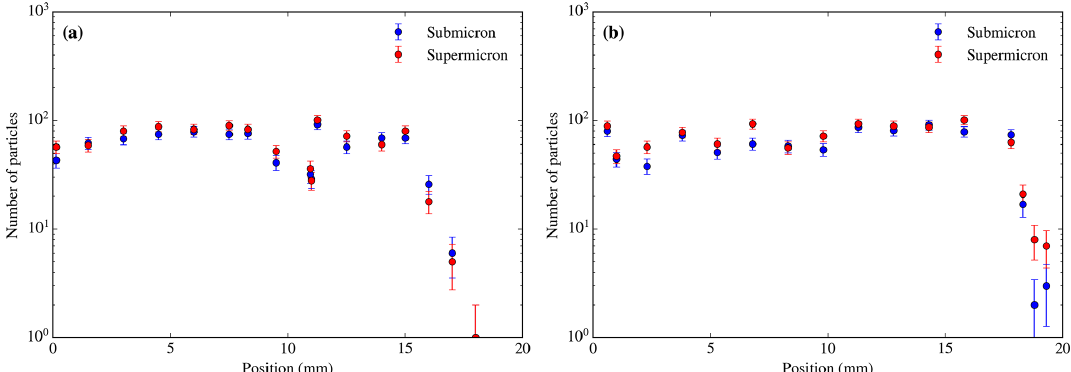
Figure 7. Radial distribution of the particle test on the sample collected on 2 October 2017 (flight C059) from 16:24 to 16:40UTC at about 320m in altitude in southern Iceland, using the lower line and open bypass, sampling 432L. Number of submicron and supermicron particles in same size areas ( ∼ 160 × 190µm 2 ) radially distributed versus the distance from the approximate centre through a radius of the filter (a) and another trajectory from the centre of the filter deviated 30 ◦ from the first radius (b) . The analysis was performed at 20KeV and × 5000. The number of both supermicron and submicron particles remains very constant all over the surface of the filter, until reaching the edges of it (which are cover by a rubber O-ring during the sampling) and the number of particles drops to the limit of the detection within a few millimetres. The error in the number of particles comes from Poisson counting